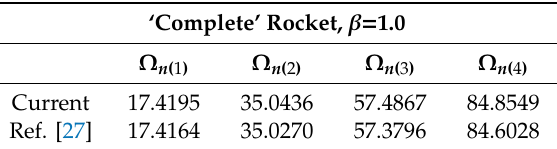
Table 2. Frequency parameters of a “complete” rocket as compared with the frequency parameters of a free-free complete cone.